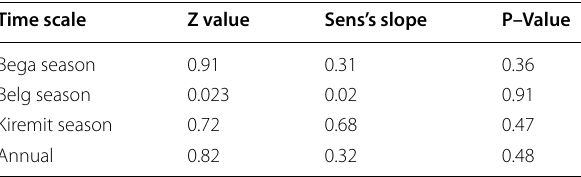
Table 3. Mean annual stream flow of the sub basin was 132.29 mm 3 /s with coefficient of variation 14.39%.